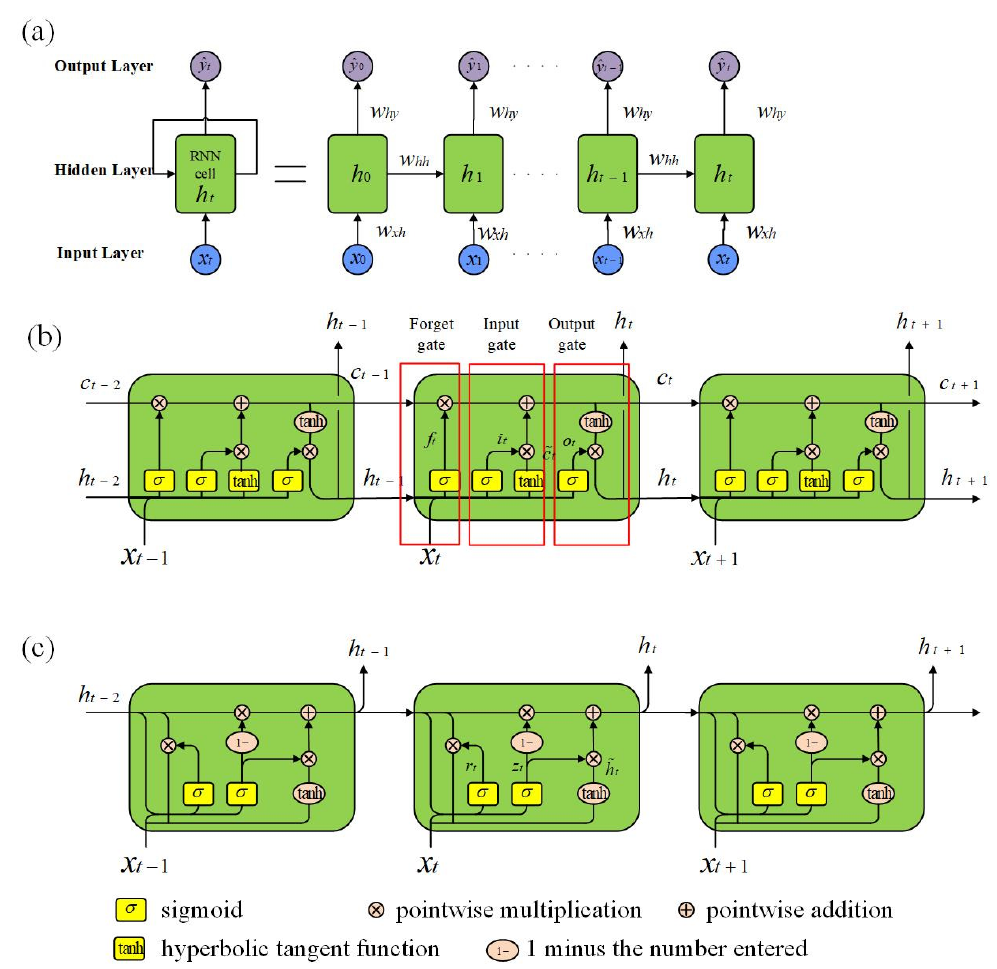
Figure 5. ( a ) Architecture of RNN; ( b ) schematic diagram of LSTM; ( c ) schematic diagram of GRU.